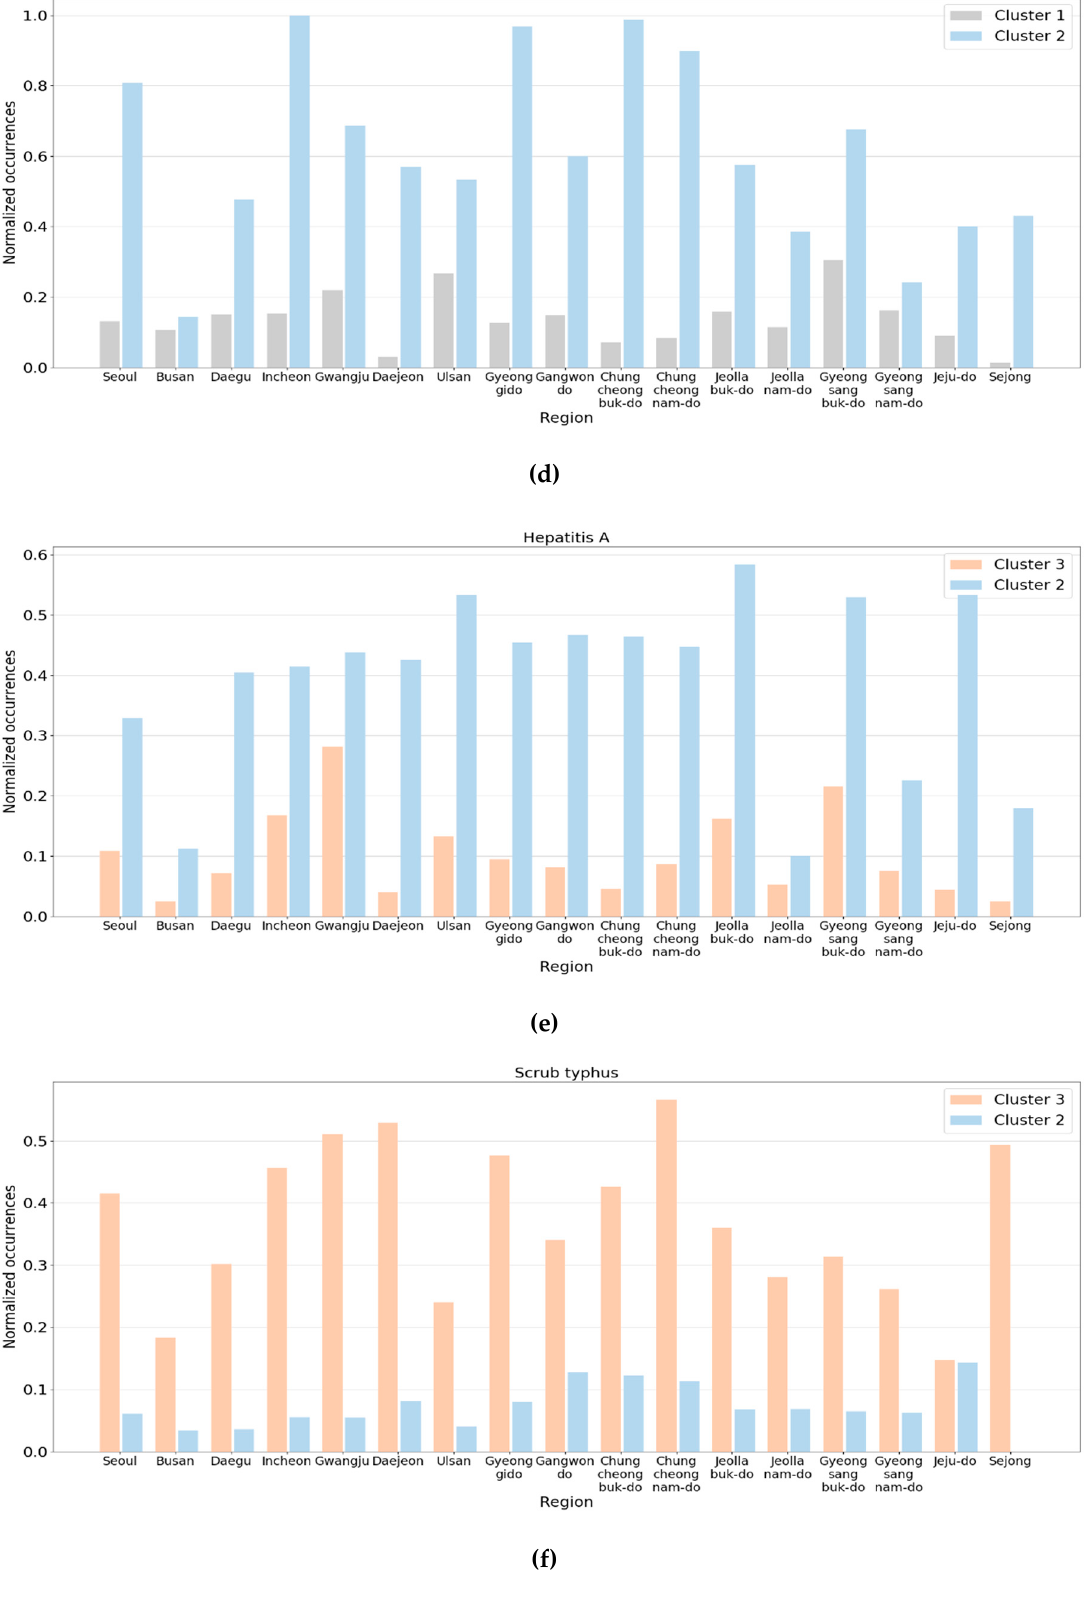
Figure 9. Comparison of normalized occurrences of infectious diseases between clusters: ( a ) measles in Clusters 1 and 4; ( b ) scarlet fever in Clusters 1 and 4; ( c ) shigellosis in Clusters 1 and 2; ( d ) hepatitis A in Clusters 1 and 2; ( e ) hepatitis A in Clusters 3 and 2; ( f ) scrub typhus in Clusters 3 and 2.